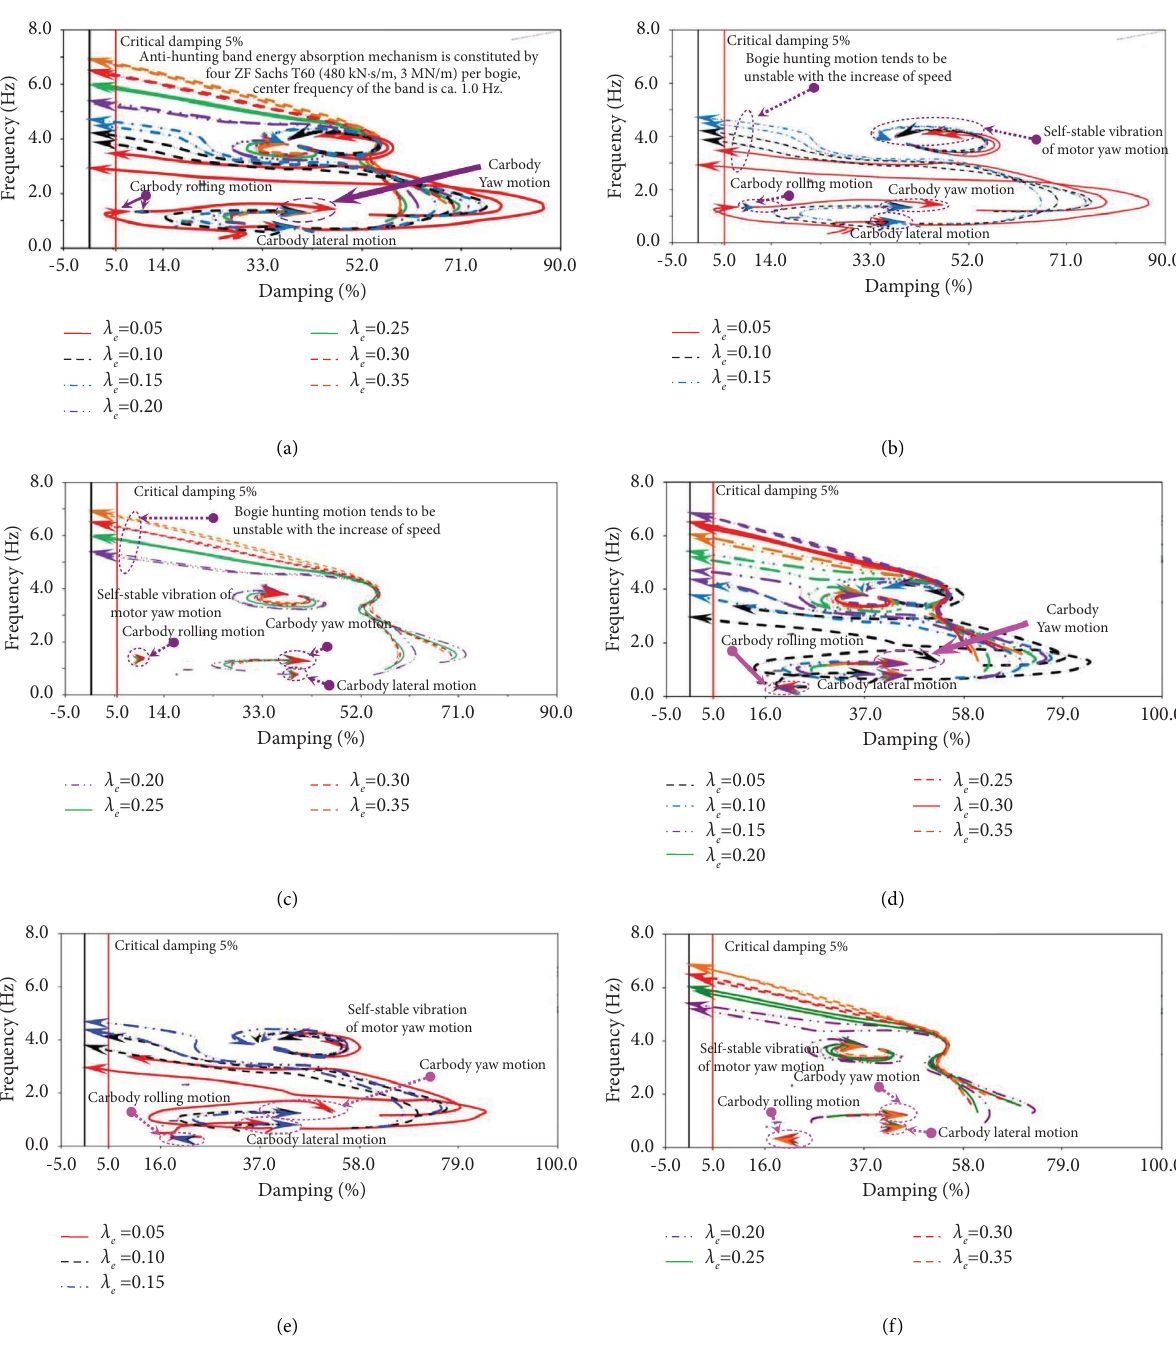
Figure 3: Analysis graphs of stability properties and variation patterns for a self-adaptive improved motor vehicle with antirolling torsion bar devices (in-) active. (a) When λ e � 0.05–0.35 with antirolling torsion bar devices active. (b) When λ e � 0.05–0.15 with antirolling torsion bar devices active. (c) When λ e � 0.20–0.35 with antirolling torsion bar devices active. (d) When λ e � 0.05–0.35 with antirolling torsion bar devices inactive. (e) When λ e � 0.05–0.15 with antirolling torsion bar devices inactive. (f) When λ e � 0.20–0.35 with antirolling torsion bar devices